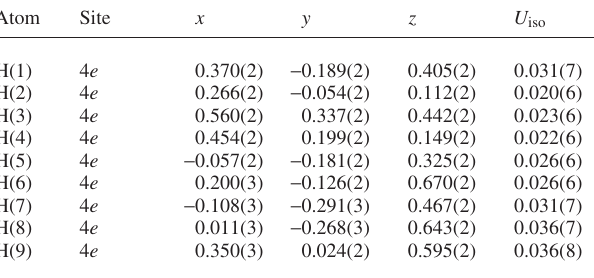
Table 2. Atomic coordinates and displacement parameters (in Å 2 )